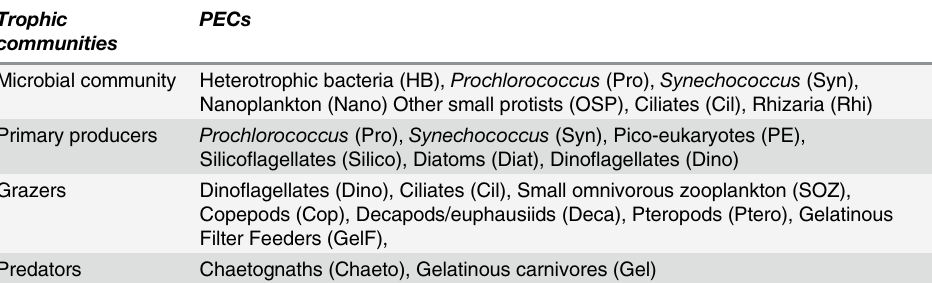
Table 2. Distribution of the 18 PECs among the 4 trophic communities used in the text. Trophic